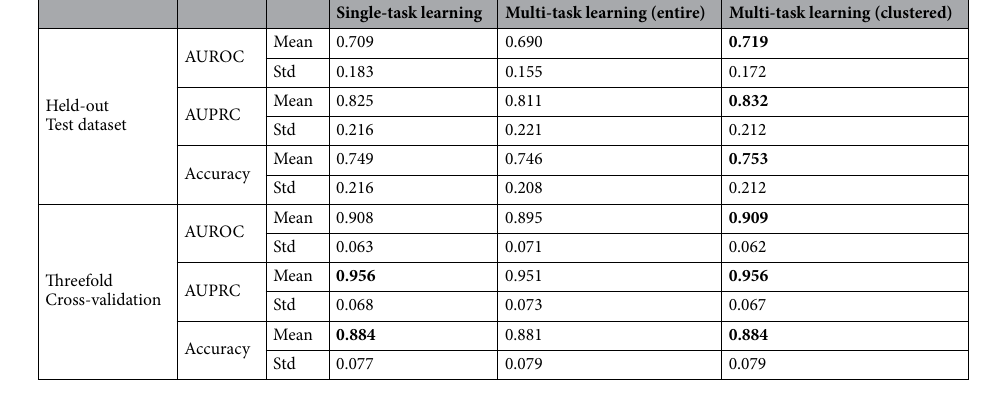
Table 2. Comparison of the single-task learning model results and results of the two multi-task learning models. The mean value is the average target-AUROC, target-AUPRC, target-accuracy over 268 targets. Significant values are in bold.